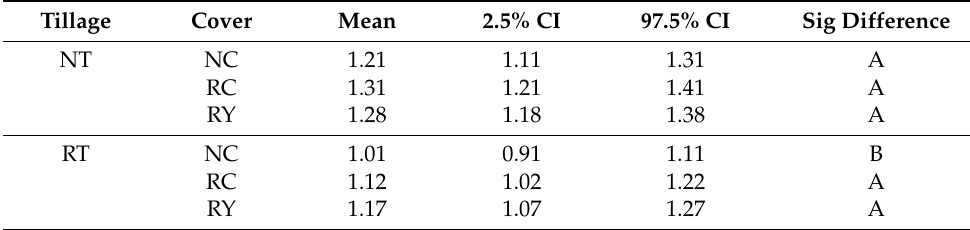
Table 1. Predicted %OC within